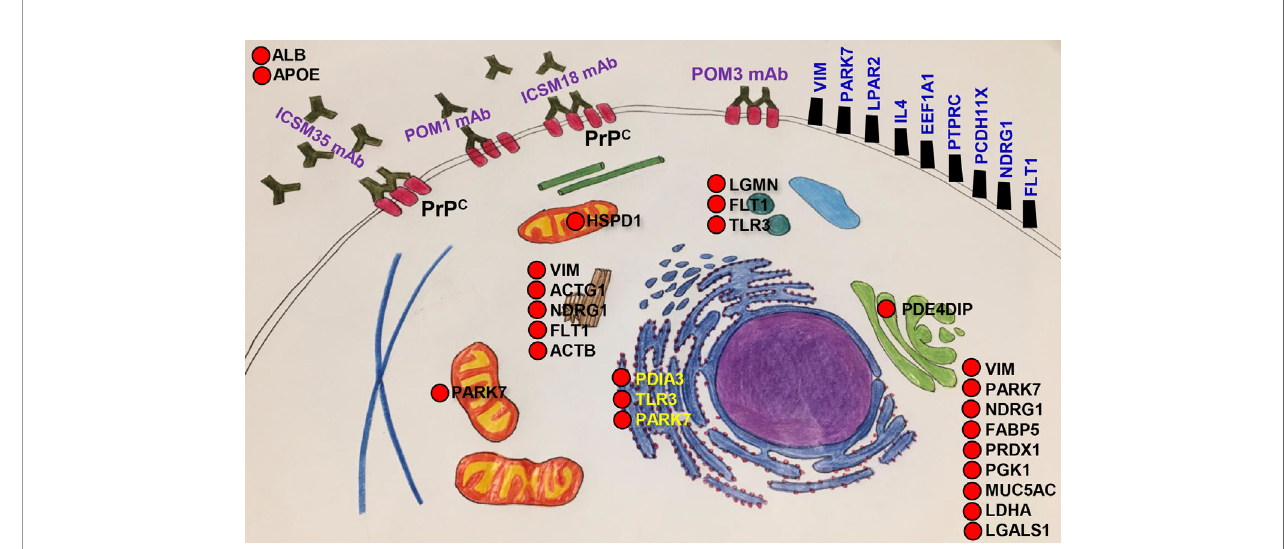
FIGURE 9 | Cellular and subcellular localisation of allergenic-related proteins. Allergenic related proteins activated following direct anti-PrP antibody and microglia treatments of neuroblastoma cell line and mouse primary neurons are grouped according to cellular